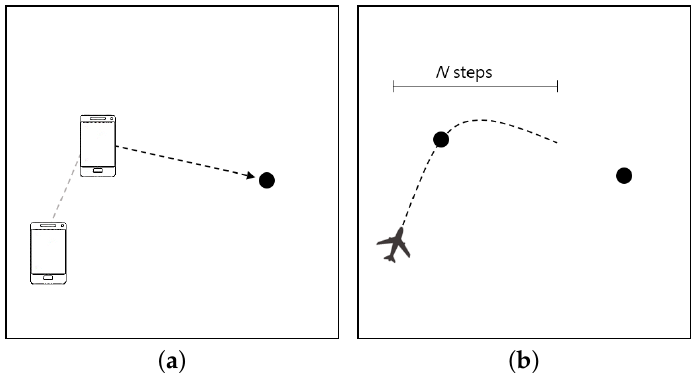
Figure 2. Examples of Random Waypoint model: ( a ) Random Waypoint model in mobile ad-hoc networks (MANET); and ( b ) Random Waypoint model in flying ad-hoc networks (FANET).